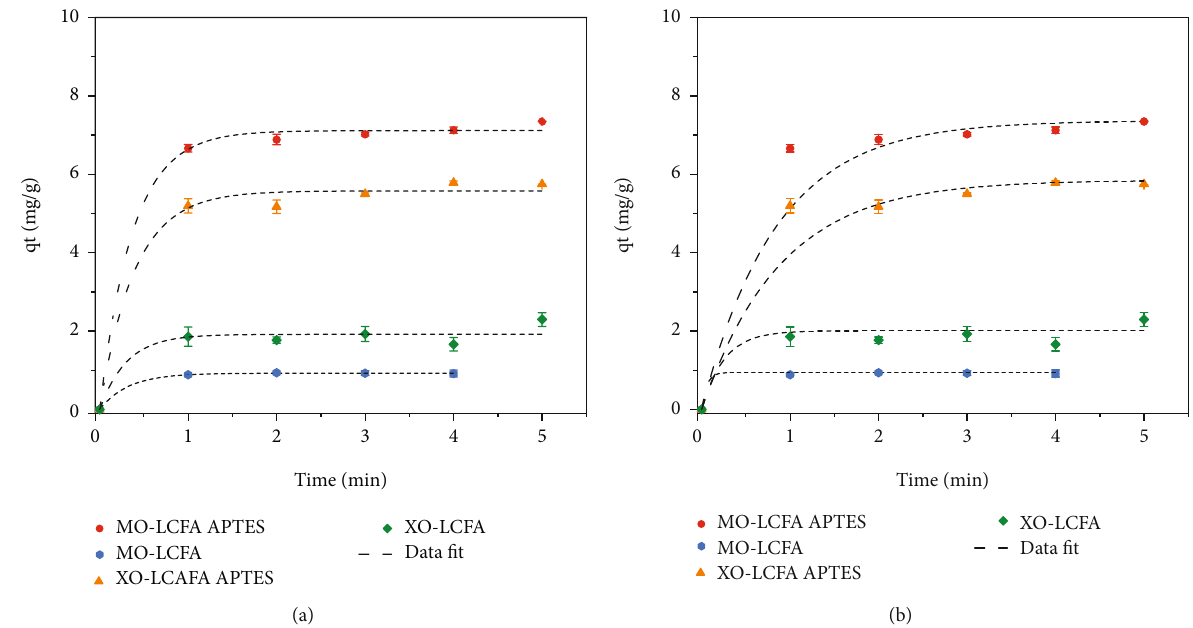
Figure 8: Adsorption kinetic and nonlinear curve fi ts (black dash line) of (a) pseudo fi rst-order and (b) pseudosecond-order kinetics for the adsorption of MO-LCFA APTES (red circle), MO-LCFA (blue hexagon), XO-LCFA APTES (orange triangle), and XO-LCFA (green diamond). The error bars represent the standard deviation of at least three repeated measurements for each time value. Table 5: Kinetic analysis results for the adsorption of MO and XO on LCFA and